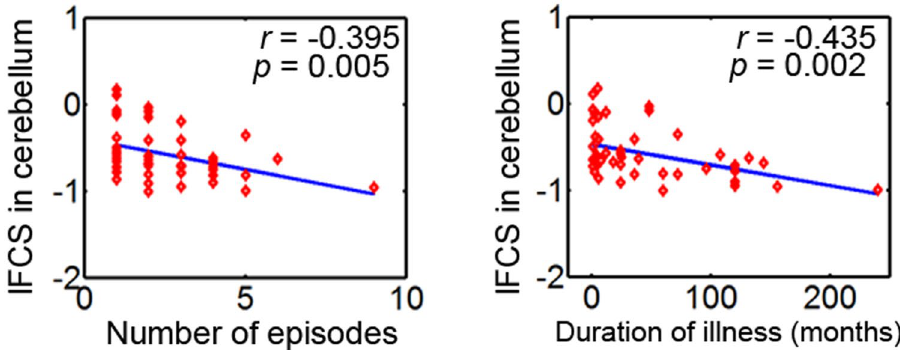
Figure 3. The relationship between the lFCS and clinical variables in the BD group ( p < 0.05, Bonferroni